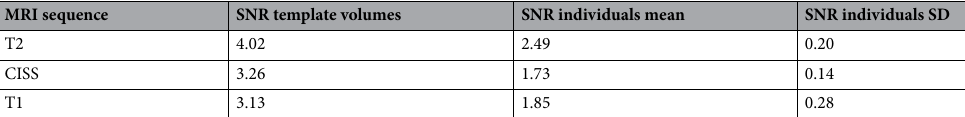
to account for global positioning and rotation, without any scaling or deformation of the CT morphology. An overlap of both templates can be seen in Fig. 2. Both templates have a remarkably high overlap, both in terms of Dice overlap coefficient 49 (Dice overlap CT/CISS: 0.830, Dice overlap CT/T2: 0.861), as well as in terms of low surface average distances on the order of 0.1–0.2 mm (CT/CISS: min − 1.36 mm, max 0.34 mm, mean − 0.13 mm, 5th percentile − 0.52 mm, 95th percentile 0.12 mm; CT/T2: min − 0.94 mm, max 0.72 mm, mean 0.11 mm, 5th percentile − 0.43 mm, 95th percentile 0.45 mm). Surface models of the anatomic regions were further annotated in the template space of IE-Map and are visualized in Fig. 1 (panels f and g). Surface meshes of semi-circular canals, crus and ampullae were manually fine-tuned, after transfer from a micro-CT atlas 11 , cochlear scalae and cupula were segmented semi-manually based on contrasts in the CISS template, while utricle, saccule and cochlear duct were augmented from the micro-CT atlas through non-linear transformation.